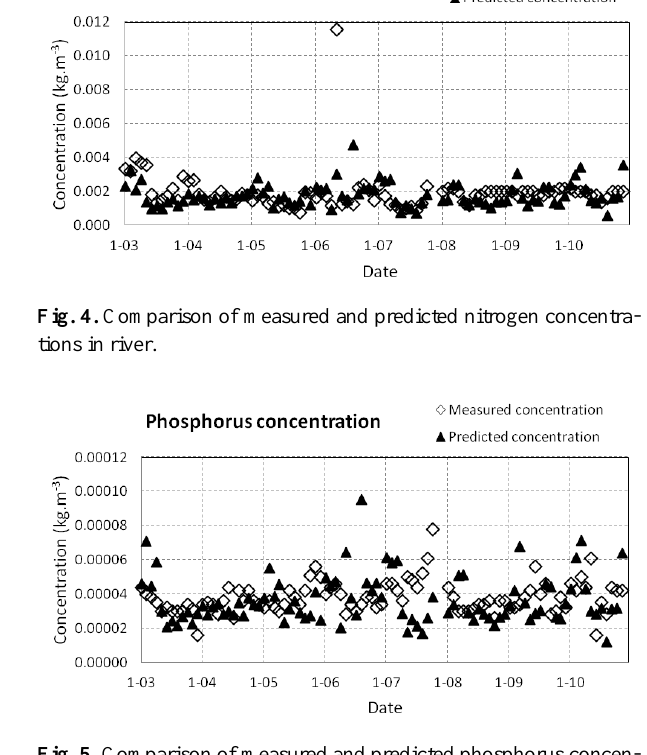
Table 1. Values of relevant arguments and measured nitrogen and phosphorus concentrations.